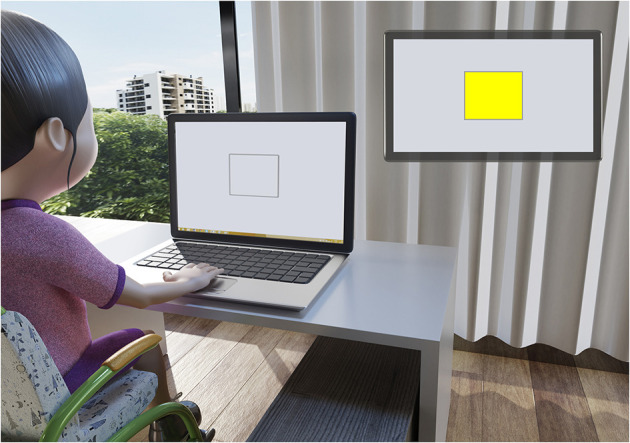
Reaction time task.